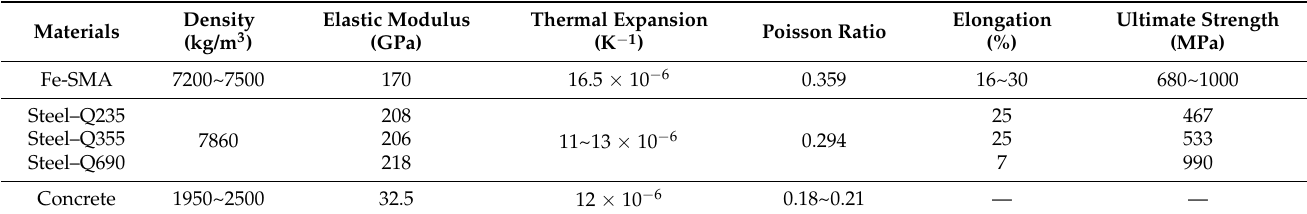
Table 3. Physical parameters of Fe-SMA, steel, and concrete [32,74–76].